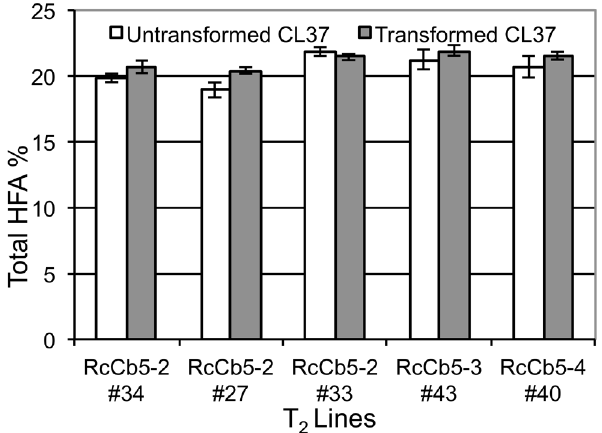
Figure 4. Total HFA accumulation in RcCb5 CL37 T selected T lines. Total HFA (18:1-OH+18:2-OH) contents of T 2 of selected homozygous lines expressing RcCb5-2, RcCb5-3, or RcCb5-4 in CL37 were compared with segregating untransformed CL37 siblings. Error bars represent standard error of the mean for four to ten individual